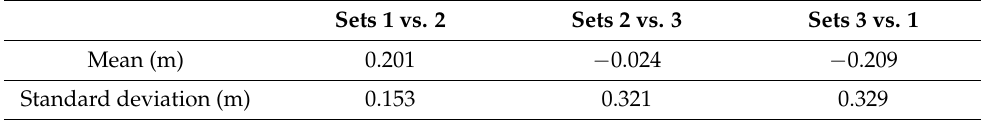
Table 3. Results of statistical analysis using the Gaussian